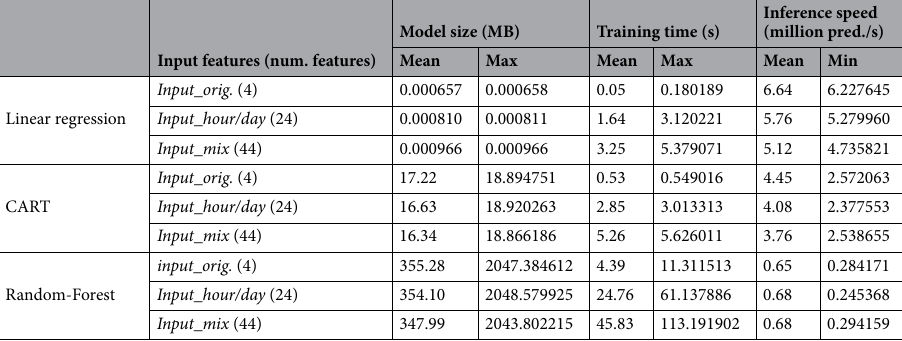
Table 2. Model size, Training time and Inference speed per ML model family and input